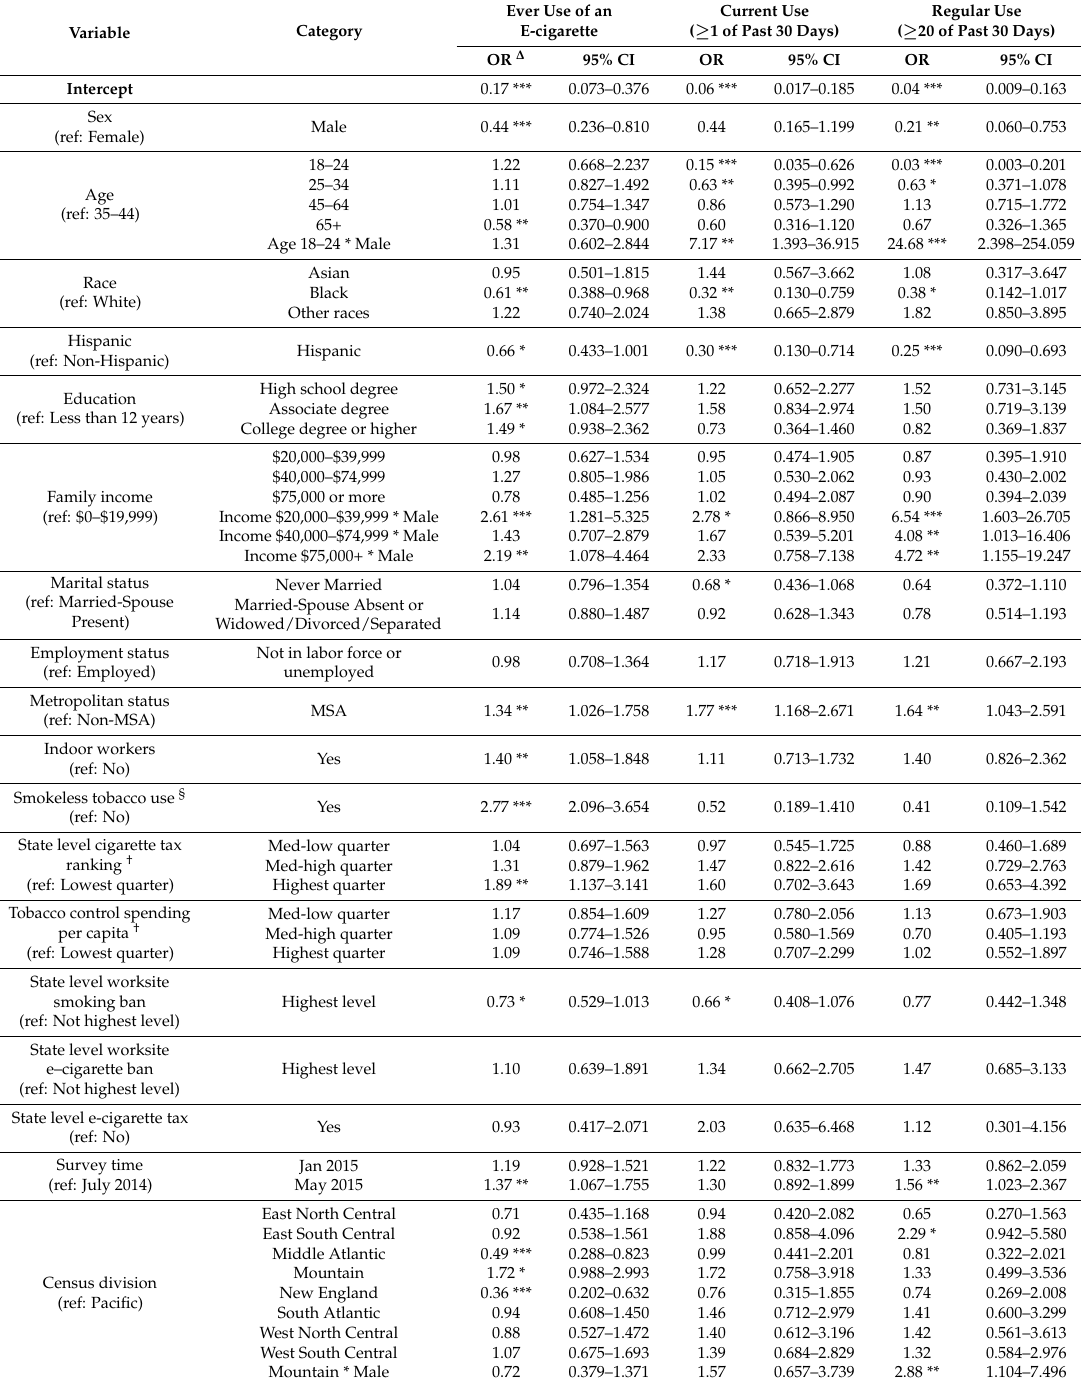
Table 4. Odds ratios for ever, current and regular use measures of e-cigarette use of former smokers who quit more than one year and less than or equal to three years, CPS-TUS, 2014/5.